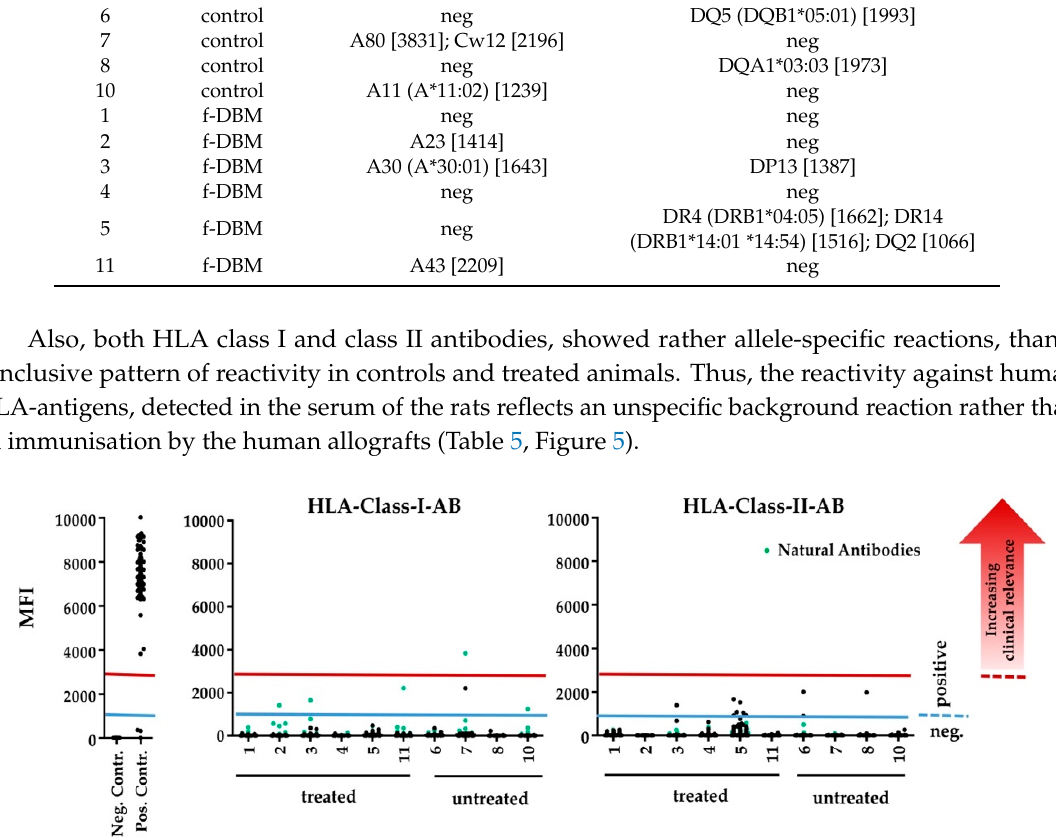
Figure 5. Reactivity against HLA-class-I- and HLA-class-II-antigens in the sera of untrated and treated animals. Each dot represents the reacitivty against a certain HLA-antigens. ‘Natural antibodies’ are marked with green dots. Antibodies with MFI ≥ 1000 were considered as positive (blue line), MFI-values ≥ 3000 were considered as clinically relevant immunization (red line).